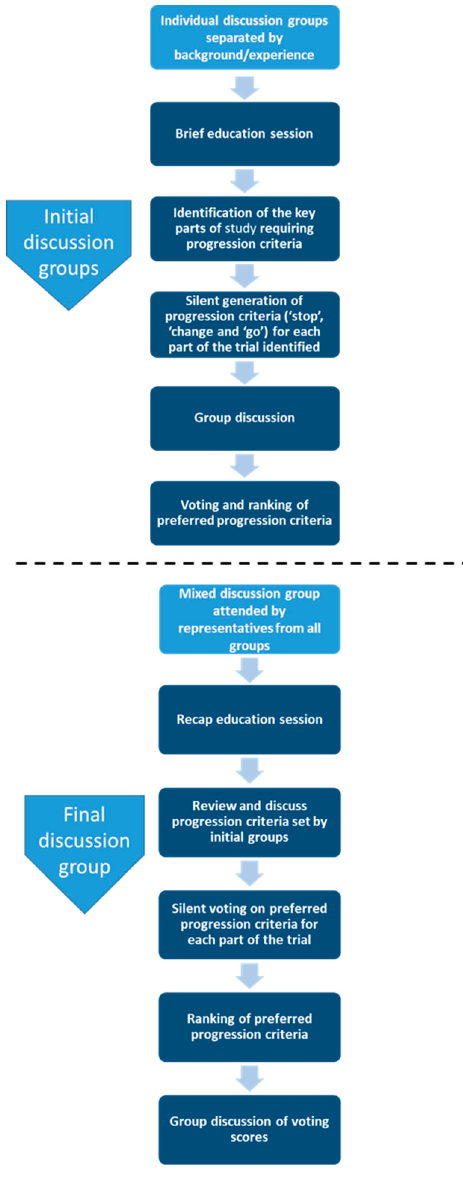
Figure 1. Adapted Nominal Group Technique Method used to establish ‘stop’, ‘change’ and go progression criteria.